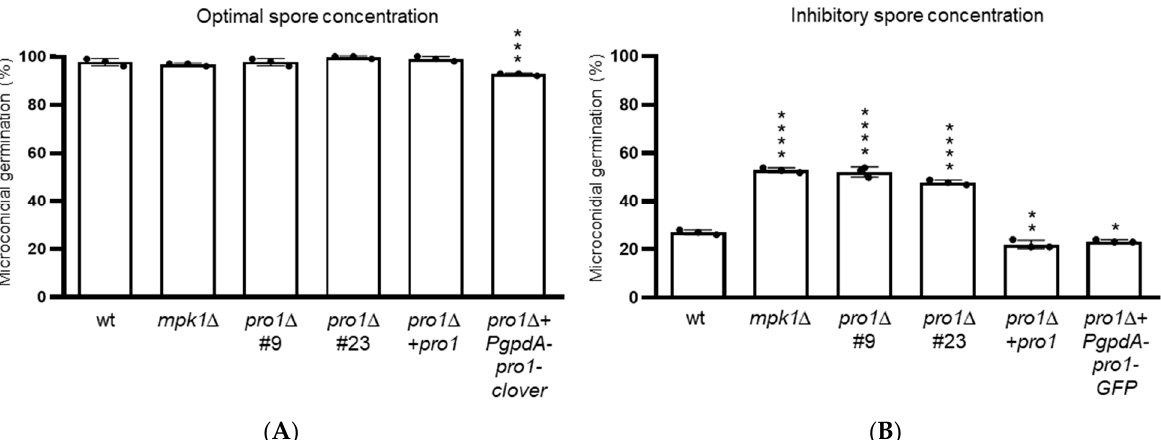
Figure 2. Pro1 is required for vegetative hyphal fusion and mycelial aggregation. ( A ) Microconidia of the indicated strains were germinated on water agar plates supplemented with 25 mM NaNO 3 . After 15 h the percentage of germ tubes undergoing vegetative hyphal fusion was determined. Data show means ± s.d. Columns with the same letter are not significantly different according to one-way ANOVA followed by Tukey’s multiple comparison test ( p < 0.05). ( B ) Formation of hyphal aggregates after 36 h growth in minimal medium supplemented with 25 mM NaNO 3 . Fungal cultures were vortexed to dissociate weakly adhered hyphae, transferred to a multiwell plate and imaged under a Lumar V12 stereomicroscope equipped with an AxioCam MR5 camera.